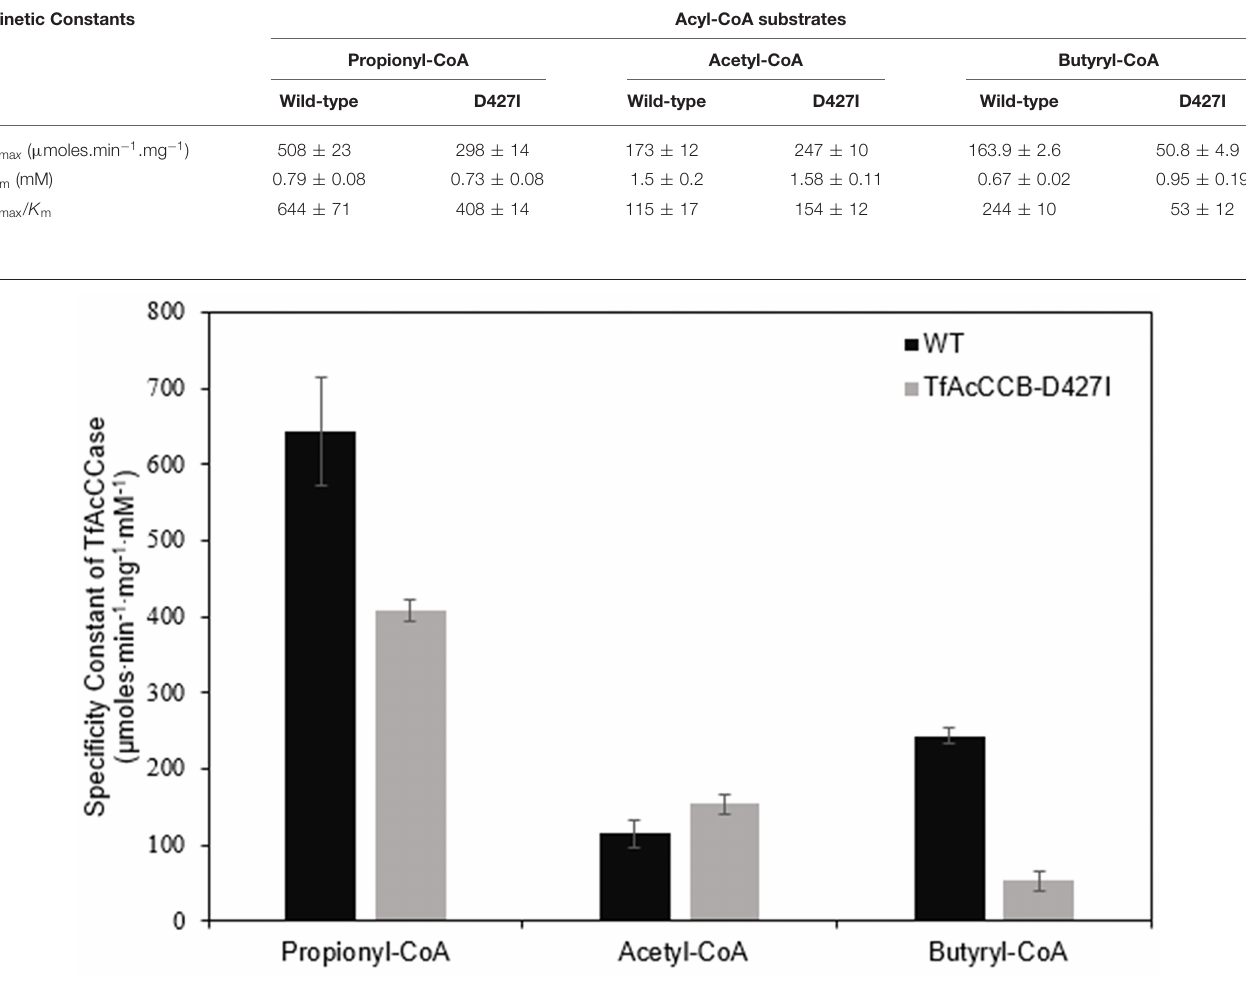
FIGURE 6 | Comparison of the specificity constants of TfAcCCase preparations that are constituted with either the wild-type TfAcCCB or the TfAcCCB-D427I mutant subunit. Data-points are the average of triplicate assays ( + SE) with either acetyl-CoA, propionyl-CoA or butyryl-CoA as the substrate. These experiments were conducted with two different enzyme